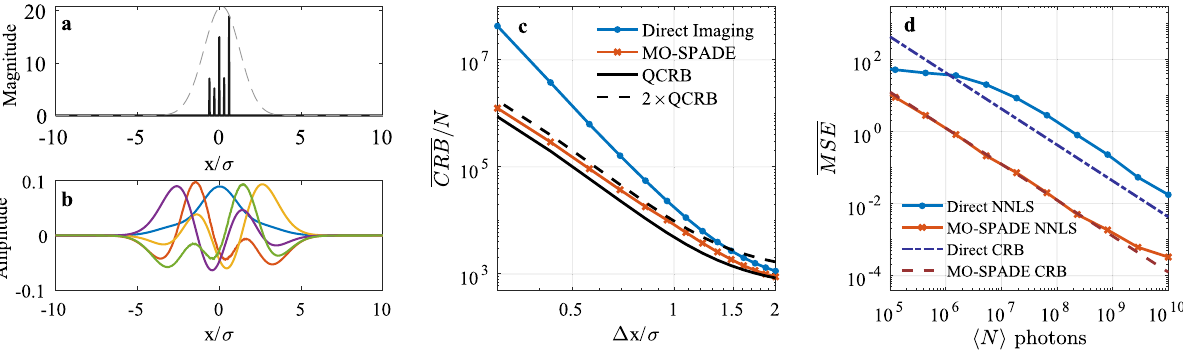
Figure 2. Demonstration of MO-SPADE imaging on point sources. ( a ) Source distribution of 5 equidistant point sources, shown here for a separation of � x = 0.3 σ . The dashed curve shows the outline of the PSF- convolved distribution in the image plane. ( b ) The manifold-optimized spatial imaging modes for the point source distribution. ( c ) The CRB averaged over all point source magnitude coefficients plotted at various point source separations. ( d ) Results of the Monte Carlo simulations for a point source separation of � x = 0.3 σ . Each data point represents the MSE of 100 trials averaged over all point source